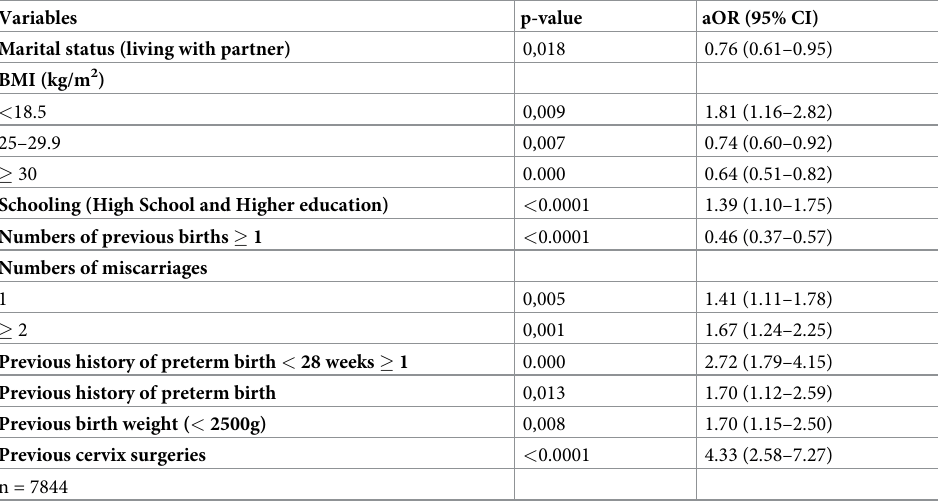
Table 3. Multiple analysis for cervical length � 25 mm.